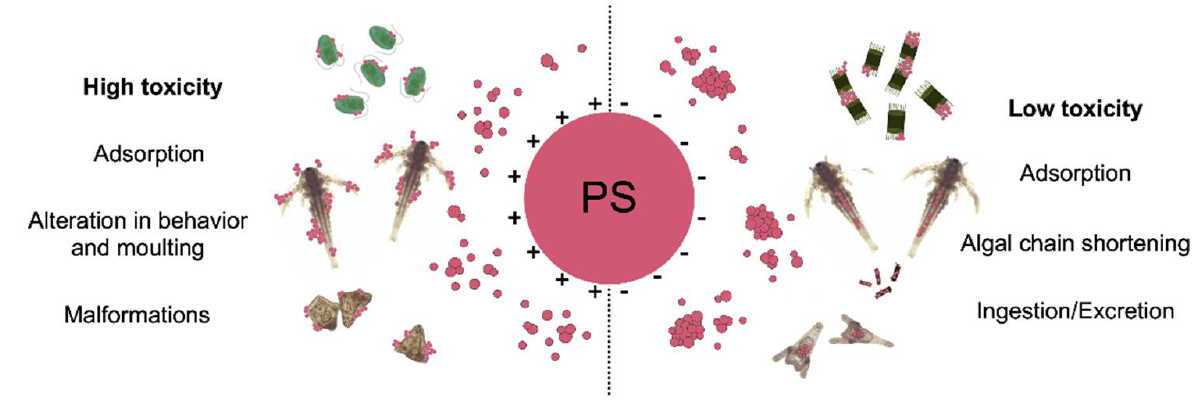
Figure 5. Behavior and major known toxic effects of PS NPs having positive ( left ) and negative ( right ) surface charge to model marine plankton (microalgae, brine shrimps and sea urchin larvae). Not to scale.